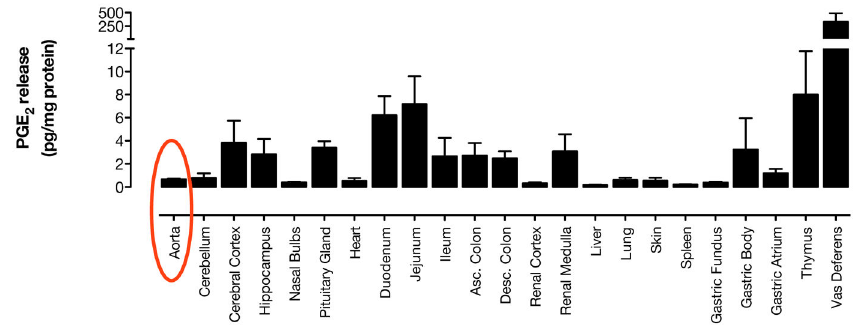
Figure 5. COX-2-dependent prostanoid production by aorta versus other mouse tissues in Cox1 -/- mice. (a) PGE normalized to tissue mass, was measured by immunoassay in supernatants of Ca 2+ ionophore A23187 (50µM)-stimulated tissue segments from Cox1 -/- mice. Cox1 -/- tissues released a variable amount of PGE substantially higher levels in the thymus, intestines, renal medulla, brain and vas deferens. This distribution correlates well with luciferase expression in organs of the Cox2 fLuc/+ mouse, as described in Figures 3 and 4. n=6. doi: